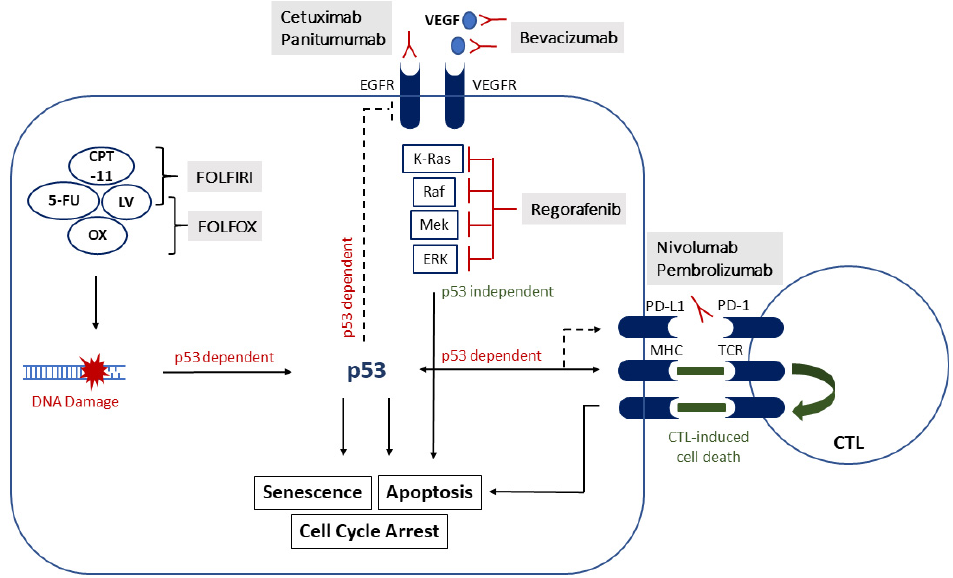
Figure 1. The association of p53 and systemic treatment in colorectal cancer (CRC). Several pathways to induce apoptosis or cell cycle arrest are p53 dependent and; therefore, mutations could possibly affect treatment response. Other pathways seem to be more independent of p53, which provides a potential target in p53 mutated tumors. 5-FU, 5-fluoruracil; CPT-11, Irinotecan; LV, Leucovorin; OX, Oxaliplatin; FOLFOX, combination of 5-FU, LV and OX; FOLFIRI, combination of 5-FU, LV and CPT-11; VEGF, vascular endothelial growth factor; VEGFR, vascular endothelial growth factor receptor; EGFR, epidermal growth factor receptor; PD-L1, programmed cell death 1 ligand 1; PD-1, programmed cell death protein 1; MHC, major histocompatibility complex; TCR, T-cell receptor; CTL, cytotoxic T lymphocyte.